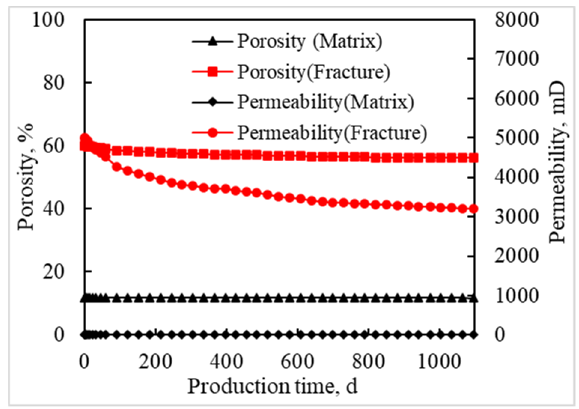
Figure 8. Evolution process of porosity and permeability.